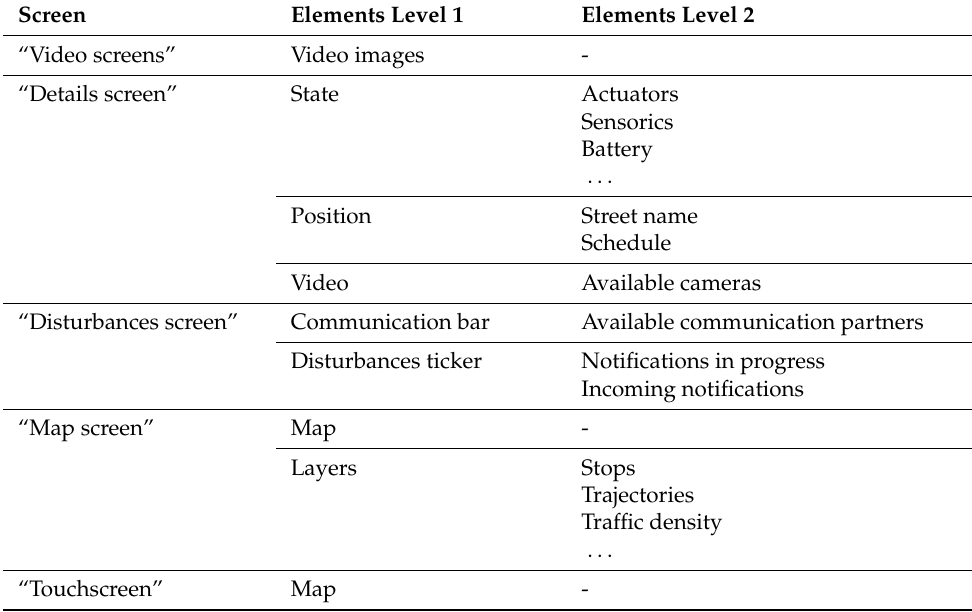
Table 1. Overview of menu structure and elements of the HMI